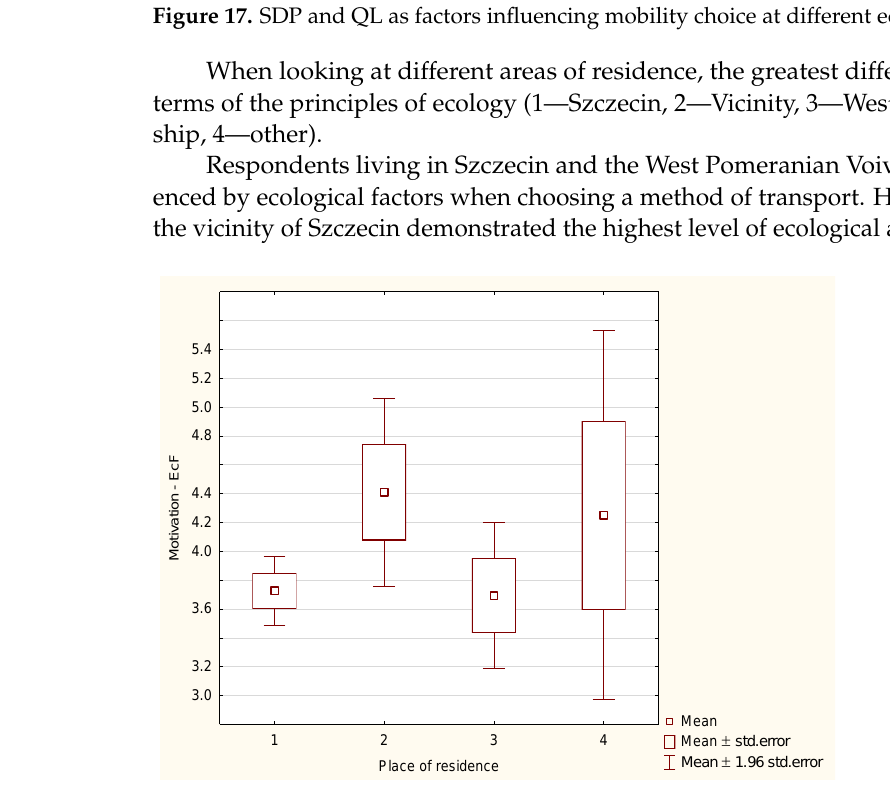
Figure 19. Accessibility: limitations to the surveyed means of transport, as indicated by the respond- ents.